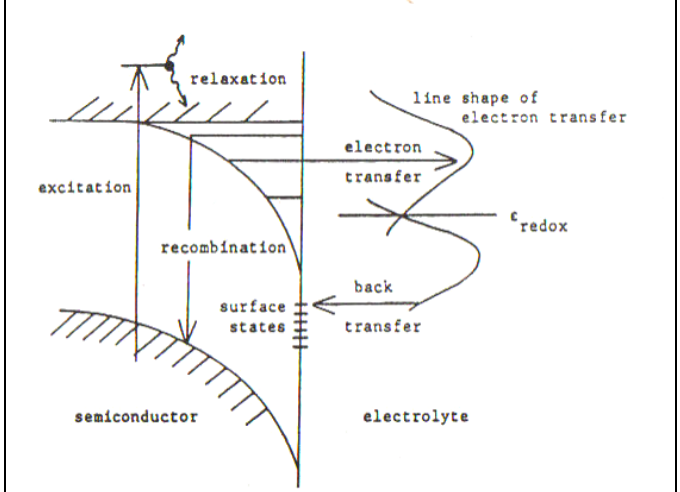
Figure 3. Electronic processes occurring at a semiconductor/electrolyte junction under illumination (Reprint from [28] and [29]).